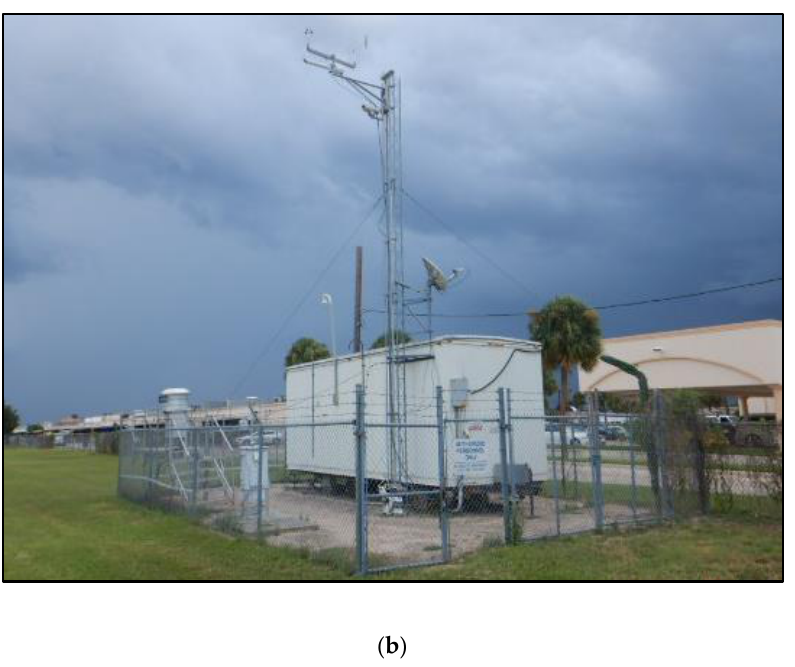
Figure 3. ( a ) A BlueSky™ Low -cost sensor at one of the study locations. ( b ) TCEQ CAMS C43 site location [54].